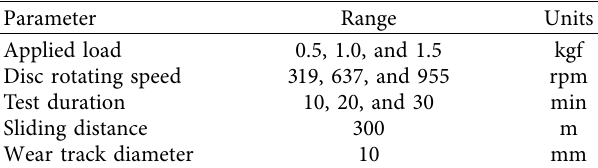
Table 3: Ball-on-disc wear test